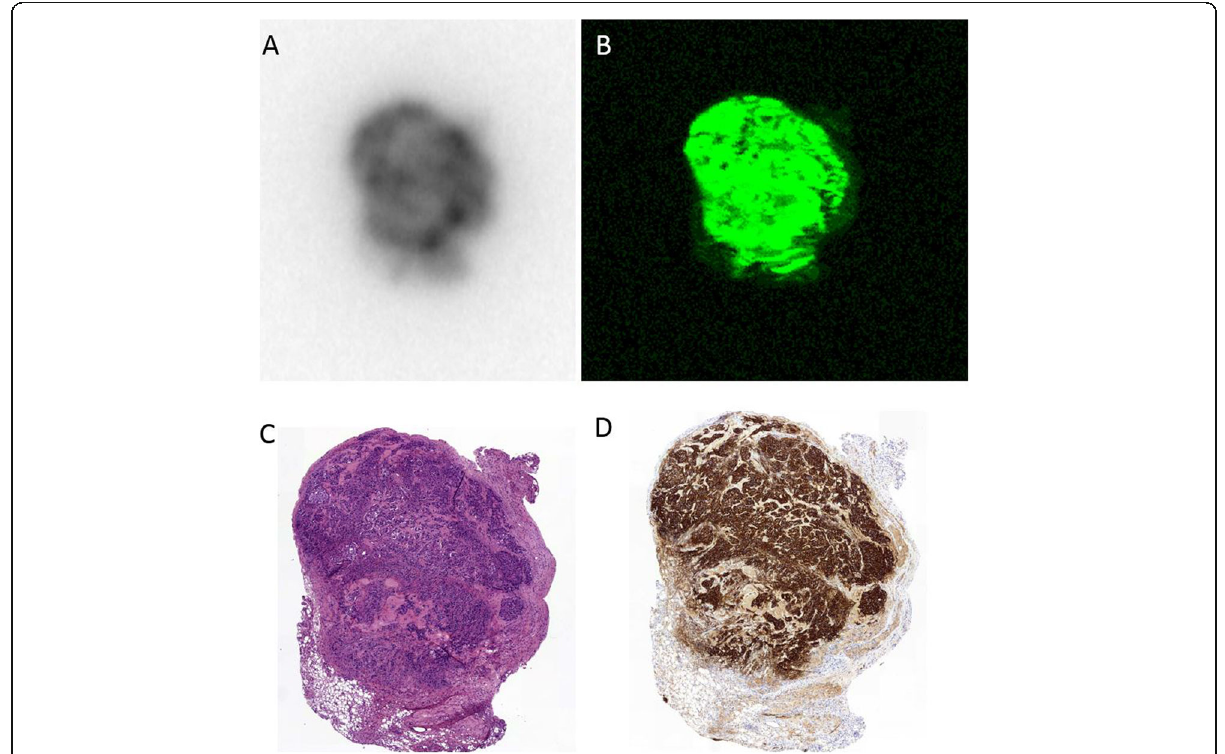
Fig. 6 Autoradiography ( a ), fluorescence imaging ( b ), and immunohistochemistry (hematoxylin and eosin ( c ) and HER2 ( d )) of 5- μ m paraffin- embedded breast tumor sections confirmed fluorescence and radioactive signals co-localized with HER2-expressing